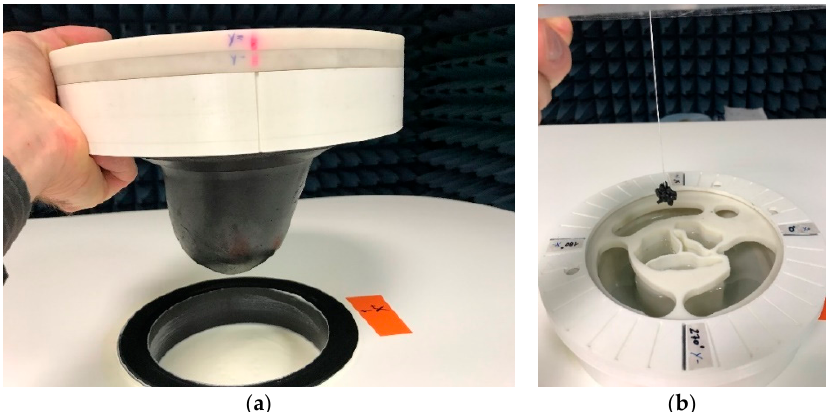
Figure 5 . The tumor phantom: microlobulated shape, average radius of 14 mm, dielectric properties matching the measured dielectric properties of excised malignant tissue. Two snapshots from the preparation of the experimental setup, before a typical validation test of the device, are shown in Figure 6.